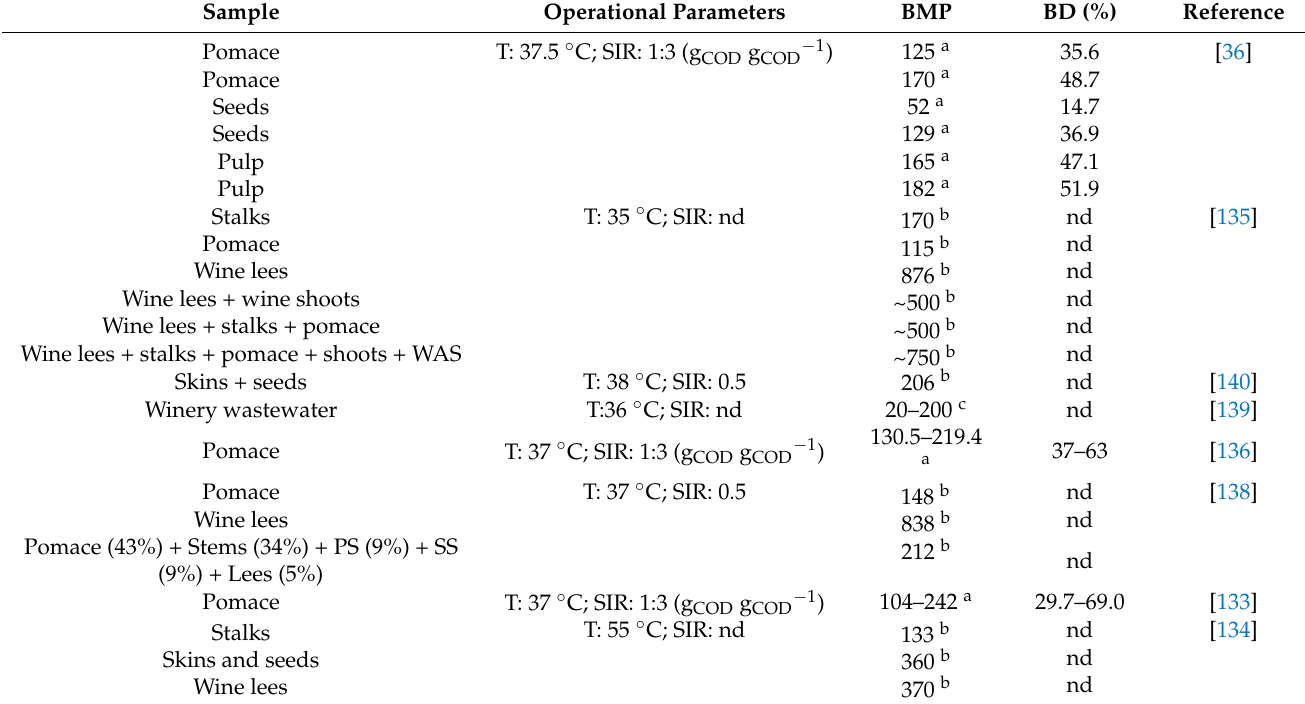
Table 14. Summary of the biochemical methane potential (BMP) of winery